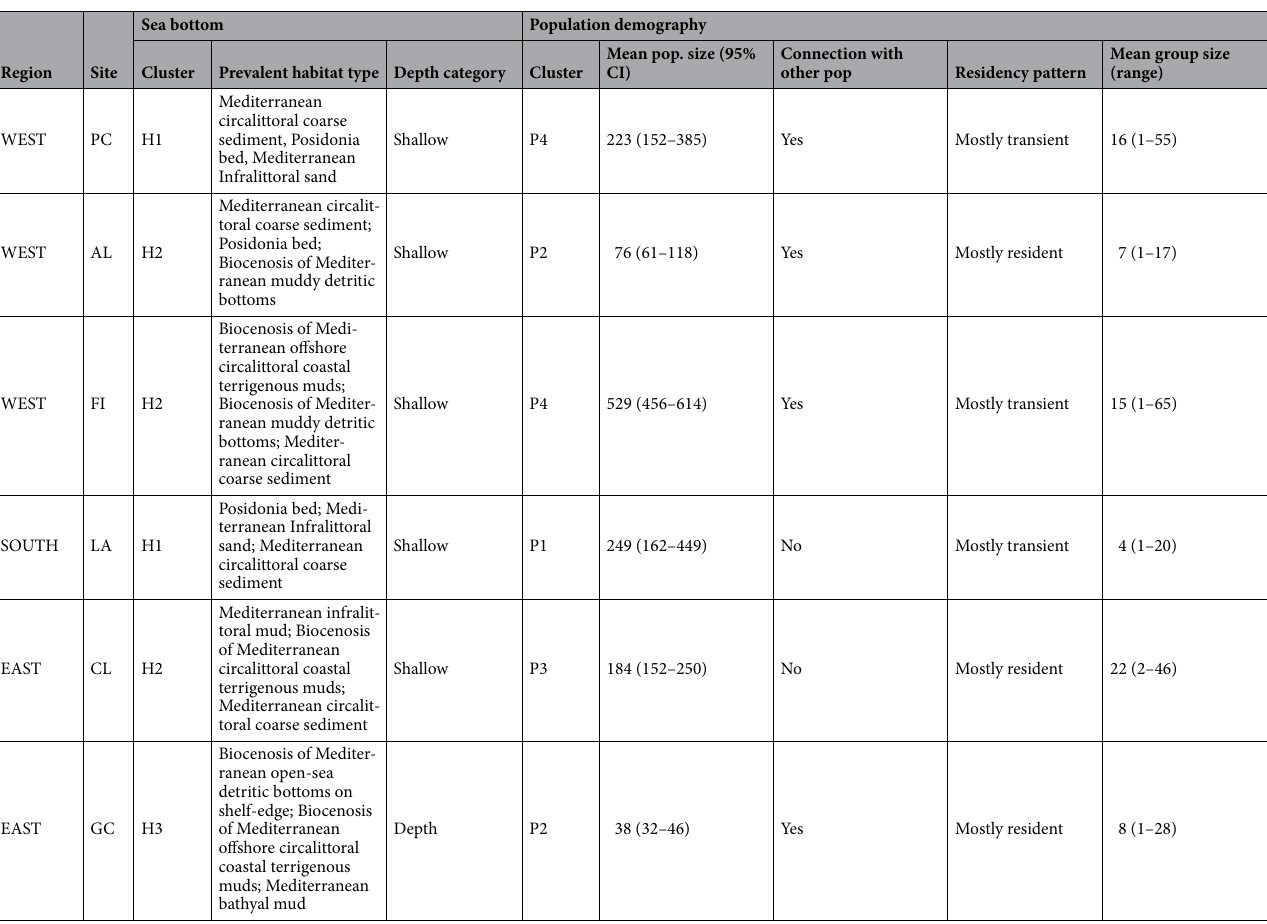
Table 5. Characteristics of the six populations studied for the four factors considered. Region: (West, East, South). Site: Port Cros (PC), Alghero (AL), Ostia-Fiumicino (FI), Lampedusa (LA), Gulf of Corinth (GC), Cres and Losinj (CL). Depth category: i) shallow (< 120 m); depth (> 120 m) Sea bottom cluster: H1, H2, H3. Population demography: P1, P2, P3, P4. Prevalent habitat types and depth were retrieved from EMODnet platform (European Marine Observation and Data Network; https:// emodn et. ec. europa. eu/